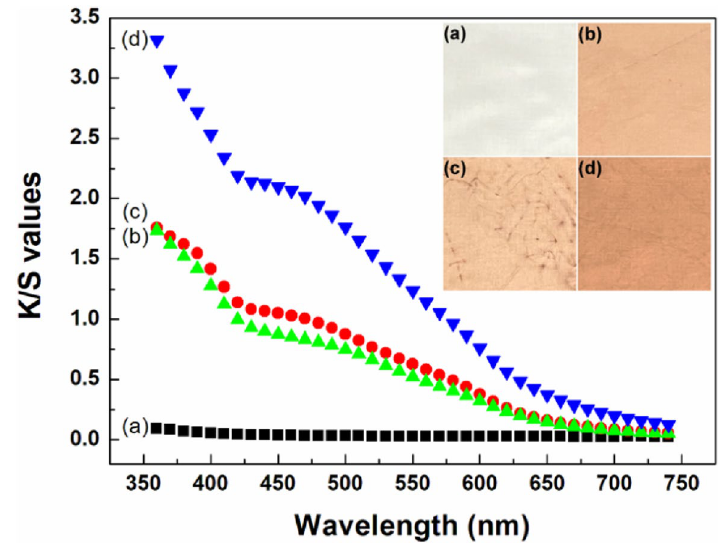
Fig. 3 K/S values and color appearance of cotton fabrics: a untreated, b dyed with Aronia berries extract, c dyed with Aronia berries extract–chitosan mixture, and d dyed with Aronia berries extract after chitosan pretreatment